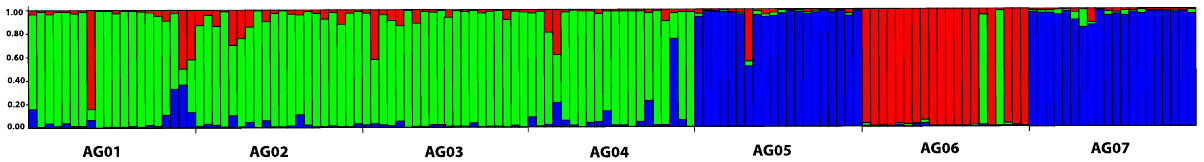
Figure 5. Population genetic structure of the seven Asynapta groverae populations determined using a Bayesian population assignment test with STRU CTU RE based on ten microsatellite loci. All individuals are shown along the X-axis. The Y-axis denotes the probability of that individual belonging to each of the genetic clusters. The most likely number of genetic clusters after Delta K Evannos’ correction is 3 ( K = 3). The population of all individuals is indicated below the